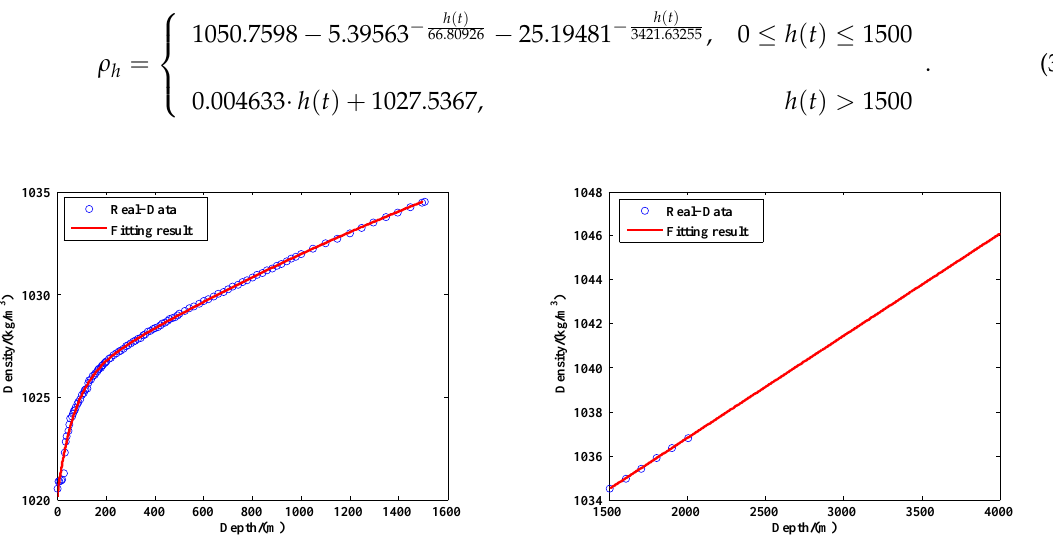
Figure 4. The fitting result of the density data at depth 0 m to 1500 m and 1500 m to 4000